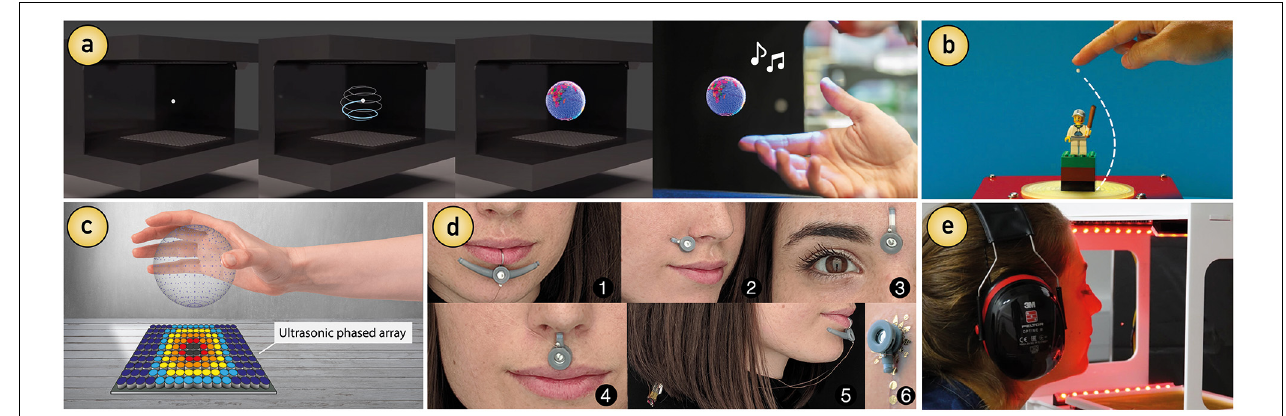
FIGURE 1 | Emerging multisensory technologies exemplifying interface and device advancements. (a) Particle-based volumetric displays (Hirayama et al., 2019). (b) Acoustic metamaterials that bend the sound (Norasikin et al., 2018). (c) Mid-air haptic 3D shapes produced by focused ultrasound (Carter et al., 2013). (d) On-face olfactory interfaces (Wang et al., 2020). (e) Gustatory experiences based on levitated food (Vi et al.,